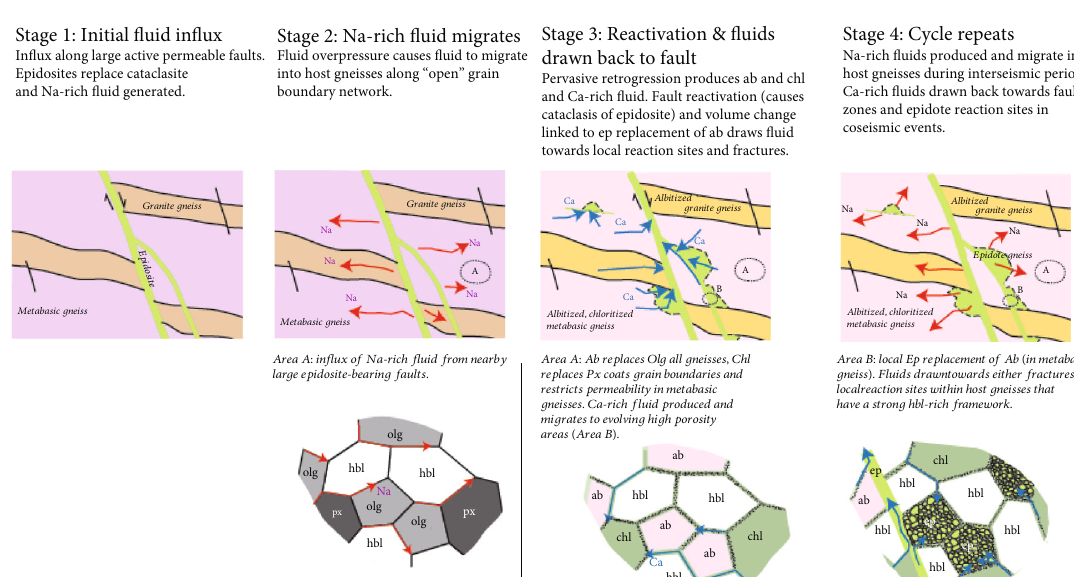
Figure 9: Model showing the progressive changes in fl uid in fi ltration history in fractured metabasic and granitic gneisses. Schematic representation of mineral reaction history shown in lower sketches for two areas (A and B) in metabasic